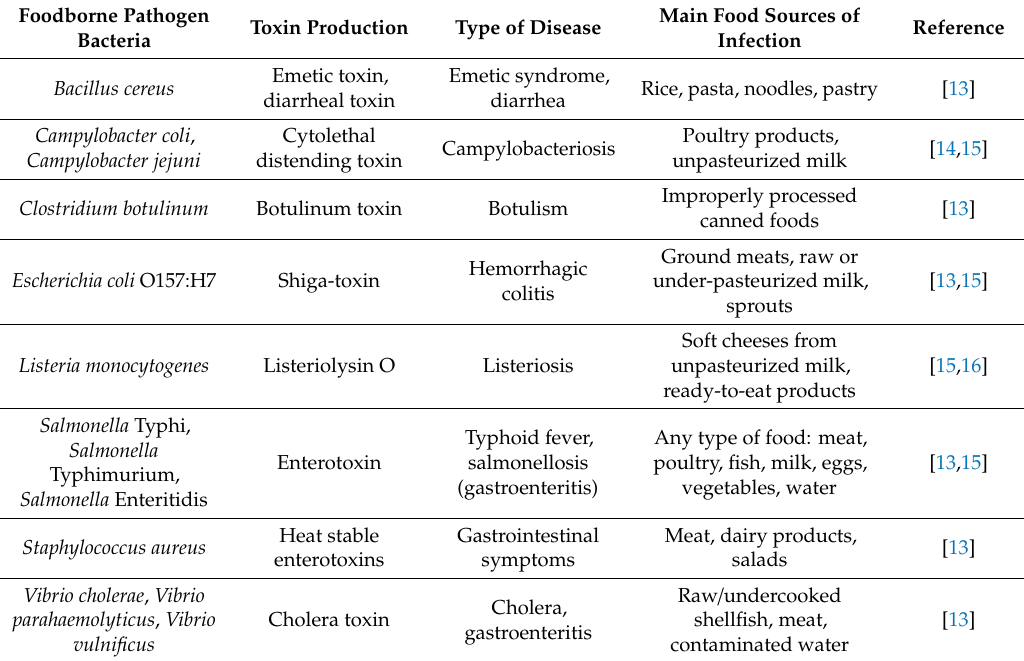
Table 1. Most common foodborne pathogenic bacteria, their produced toxins and diseases